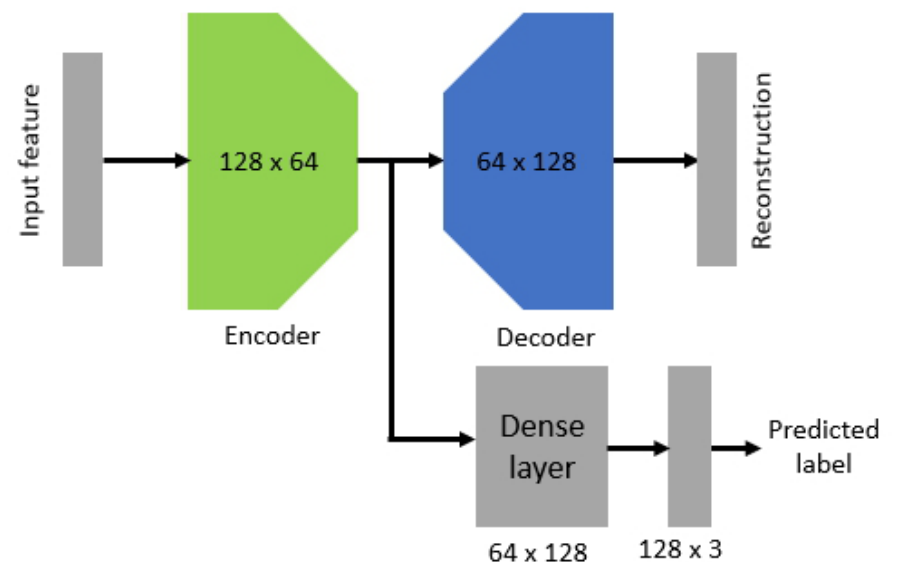
Figure A2. Proposed autoencoder model with an additional classification